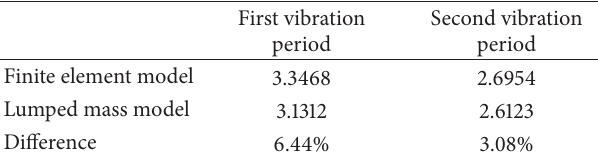
Table 1: Comparison with difference of the period between two